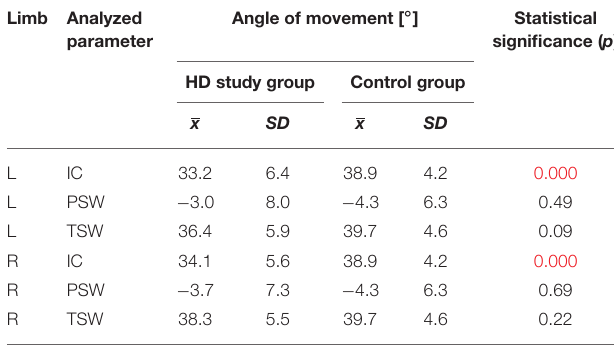
TABLE 3 | Angular changes in the ankle-shin joint compared with control group. Limb Gait Phase Angle of movement [ ◦ ] Statistical